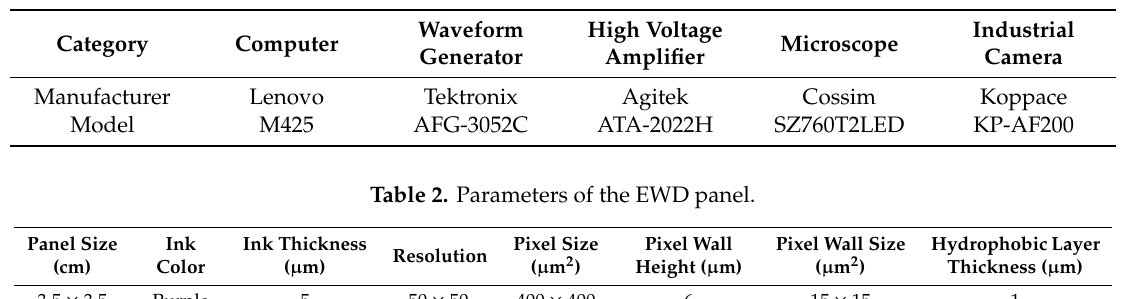
Table 1. Experimental platform for testing EWDs.